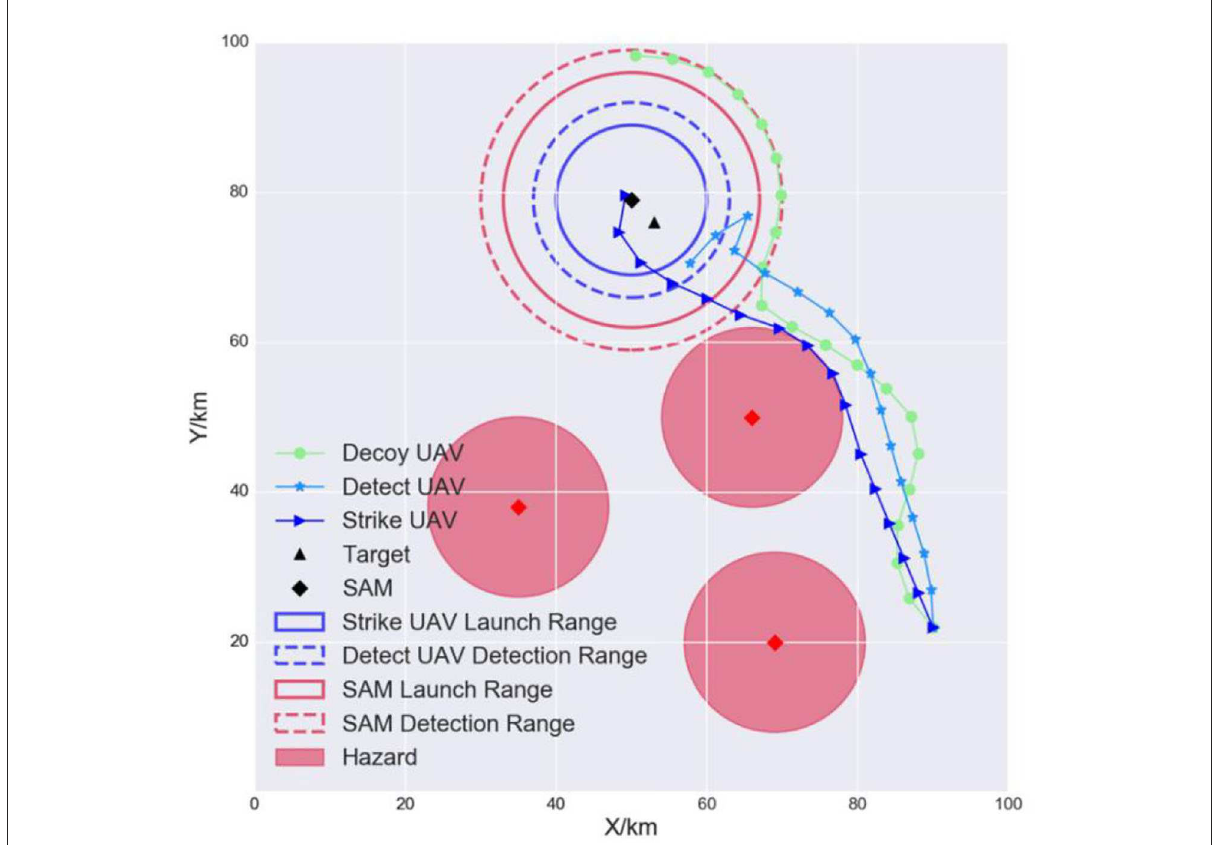
FIGURE11 Generalization of the models.